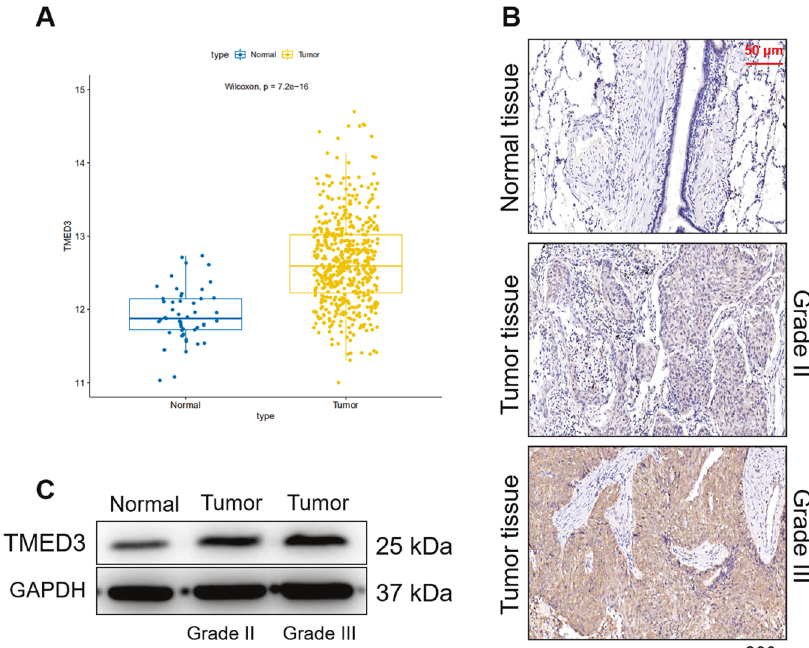
Fig. 1 TMED3 is highly expressed in LUSC. A Expression pro fi les of TMED3 were analyzed based on 501 tumor samples and 49 normal samples in the TCGA. B The expression of TMED3 in the normal and tumor samples was detected by IHC (200 × magni fi cation: scale bar = 50 μ m). C The protein expression of TMED3 in normal and tumor tissues was detected by western